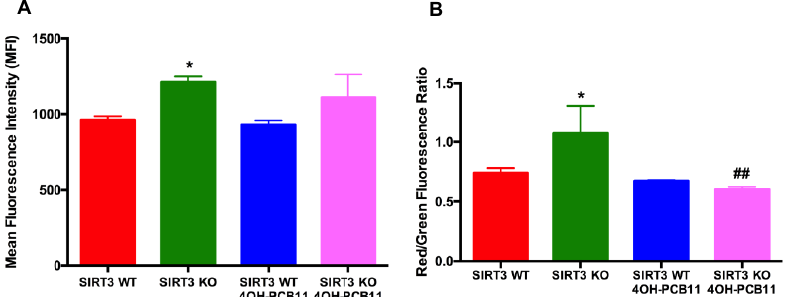
Figure 2. Steady-state levels of reactive oxygen species (ROS) and mitochondrial membrane potential were determined by Mitosox oxidation. ( A ) Asynchronous cultures of MEFs were incubated with 3 μM 4OH-PCB11 for 24 h. Cells were trypsinized, washed once with PBS, and labeled with 2 μM Mitosox (in 0.1% DMSO, 20 min) in PBS containing 5 mM pyruvate at 37 °C . ( B ) Mitochondrial membrane potential as measured by JC-1 (5 μg/mL, 15 min). The mean fluorescence intensity (MFI) of 10,000 cells was analyzed by flow cytometry. Samples were assayed in triplicate; data are the means ± 1SEM of two independent experiments, each containing three treatment dishes, n = 6. * p < 0.05 as compared to vehicle-treated WT control group. ## p < 0.01 as compared to vehicle-treated SIRT3-KO control group.